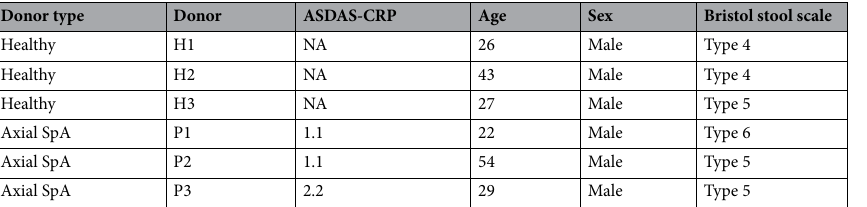
Table 1. Overview of the metadata for healthy and spondyloarthritis (SpA) fecal donors. Bristol stool scale ranges from type 1 (hard and separate lumps) to type 7 (liquid consistency) 52 . Ankylosing Spondylitis Disease Activity Score with C-reactive protein (ASDAS-CRP) to estimate disease activity 59 . Cut-off values: < 1.3 for inactive disease, 1.3–2.0 for low disease activity, 2.1–3.5 for high and > 3.5 for very high disease activity 60